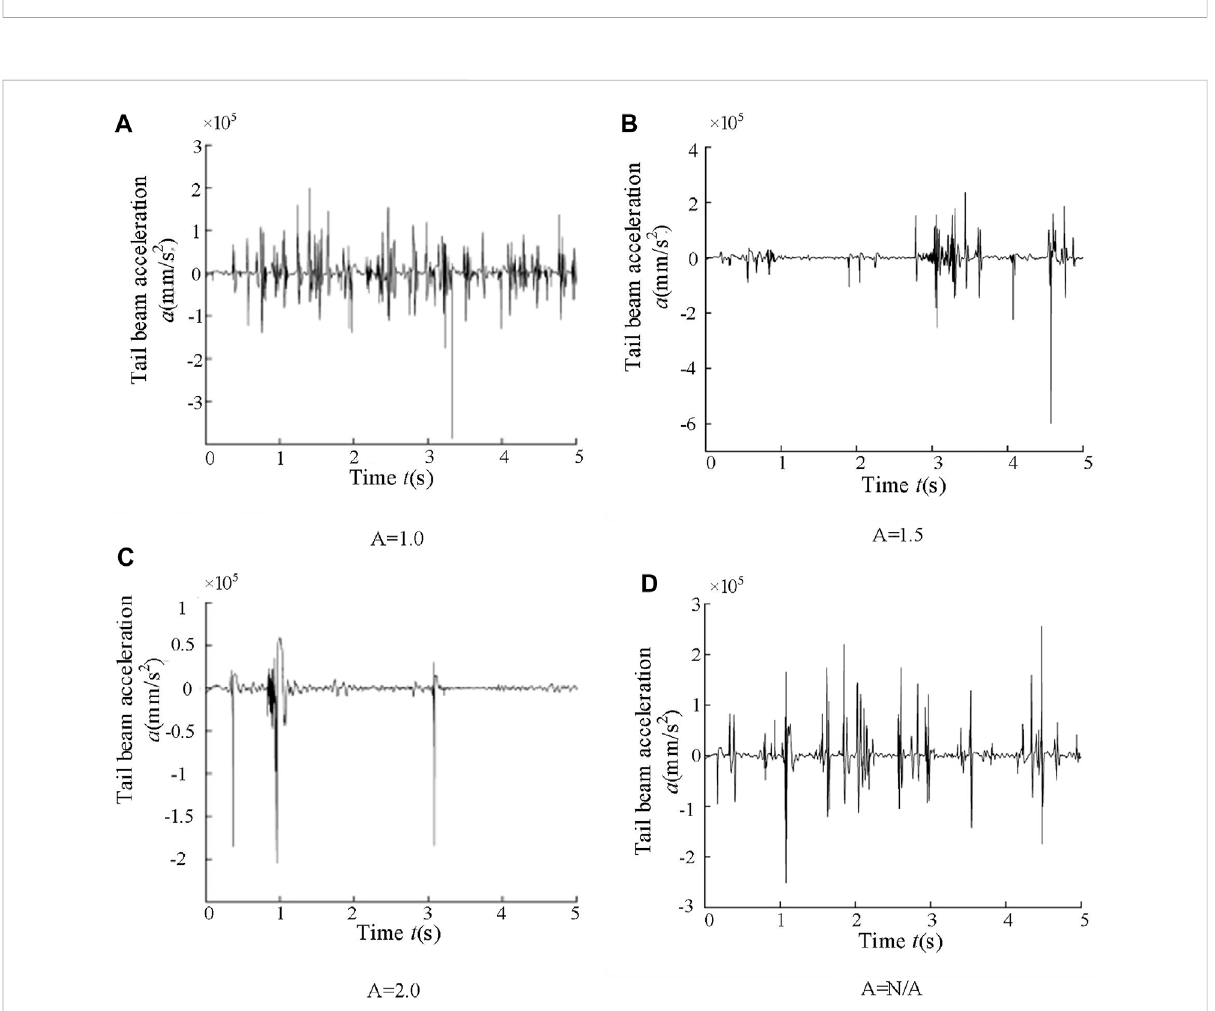
FIGURE 17 Time-domain diagram of tail beam vibration under different particle